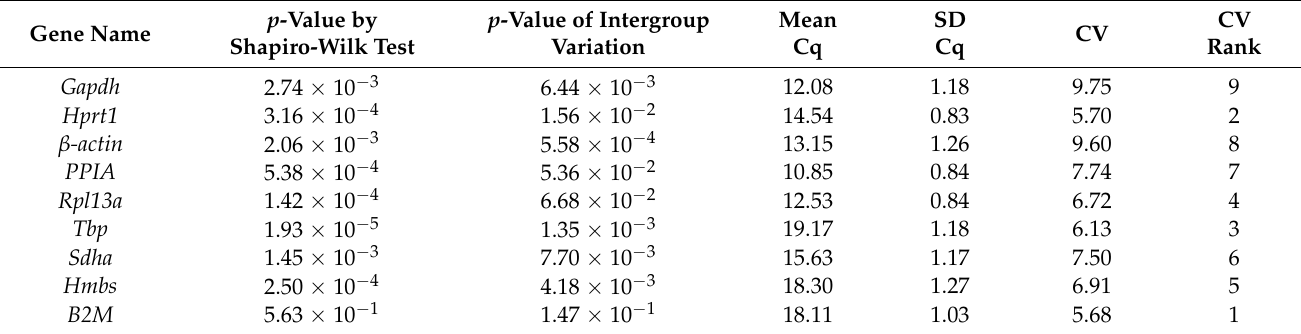
Table 6. Expression features in female hypothalamus tissues at different developmental stages analyzed by SPSS.